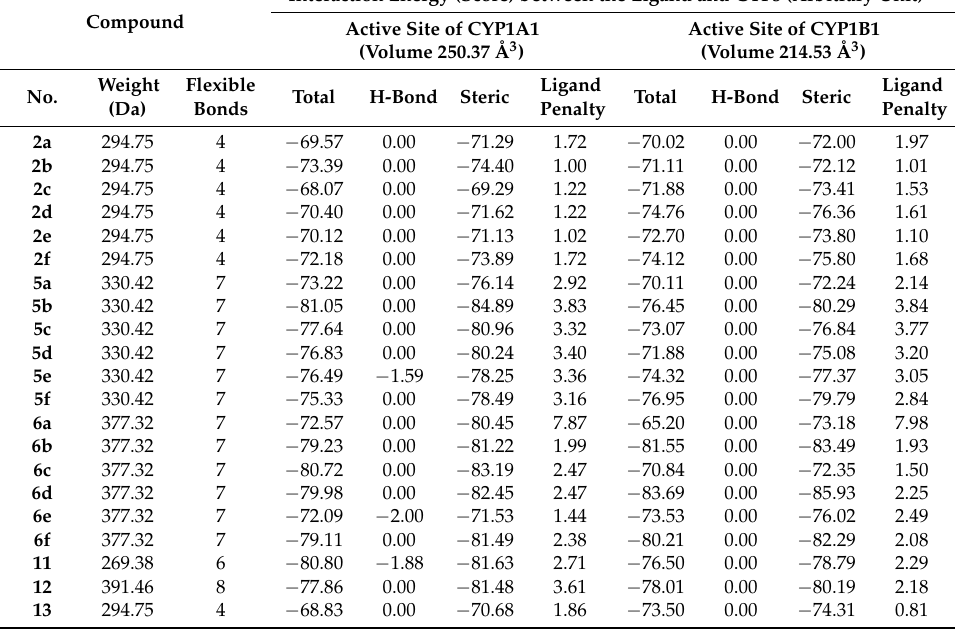
Table 2. The results of docking acetylenic sulfamoylquinolines to the active sites of CYP1A1 (PDB ID: 4I8V) and CYP1B1 (PDB ID: